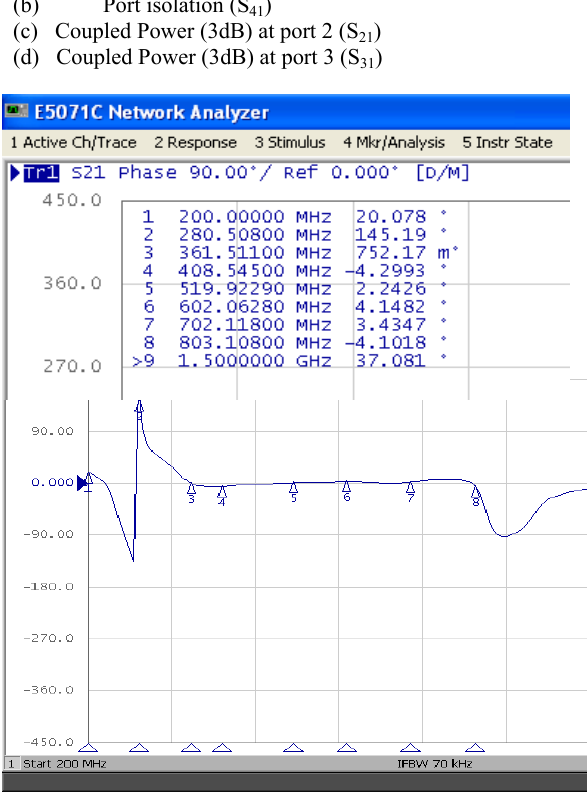
Fig.8: Measured phase balance of Rat-Race coupler